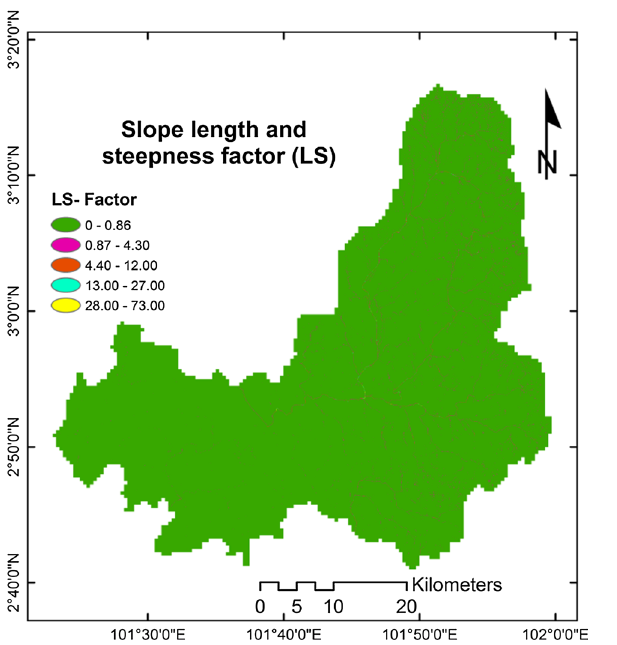
Fig. 6 Slope length and steepness factor (LS) map of the study area